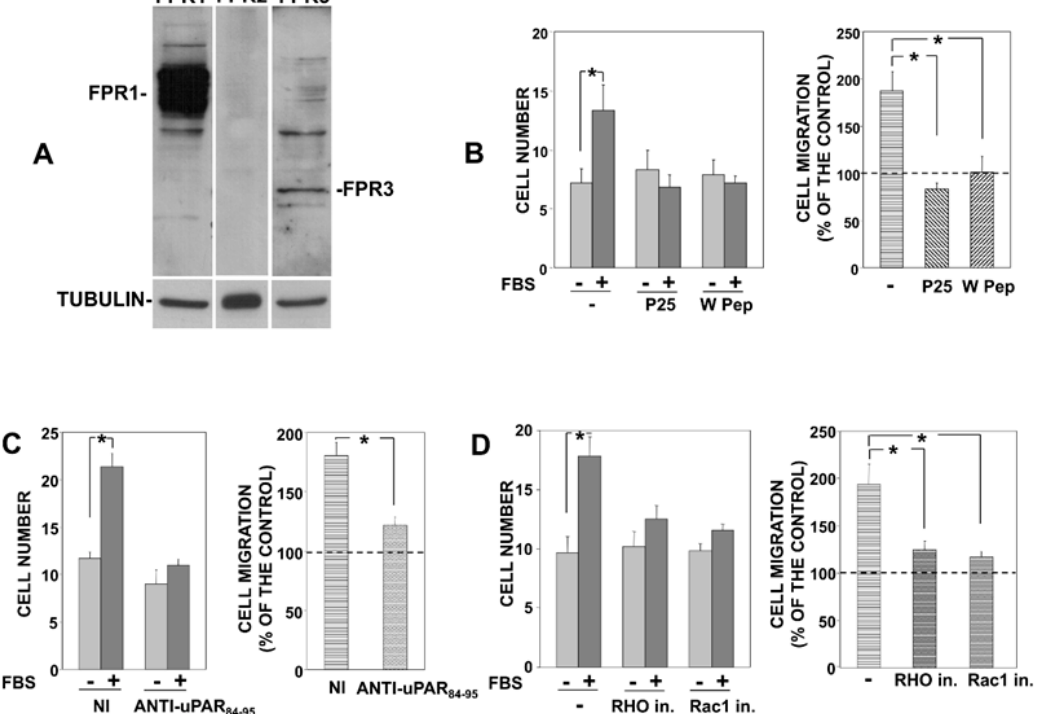
Figure 1. uPAR interactions with FPR1 and β 1 integrins are involved in migration of prostate carcinoma PC3 cells. PC3 cells were lysed and 50 µ g of cell extract was analyzed by Western blot with indicated antibodies; membranes were reprobed with an anti-tubulin mouse antibody for loading control ( A ). PC3 cells were pre-incubated with diluent ( − ) or 5 nM W Peptide (W Pep) or 50 µ M P25 ( B ) or with 5 µ g / mL nonimmune Ig (NI) or an antibody directed to 84–95 uPAR residues ( C ) or with diluent ( − ) or 10 µ M Rho kinase inhibitor or 20 µ M Rac1 inhibitor ( D ). Cells were then plated in Boyden chambers and allowed to migrate towards 10% fetal bovine serum (FBS). Migrated cells were fixed, stained with hematoxylin, and counted (( B – D ) left panels). Results of migration assays are also expressed as percentage of cells migrated towards serum over the cells migrated without serum; 100% values represent cell migration in the absence of chemoattractants (( B – D ) right panels). The values are the mean + SD of three experiments performed in triplicate. (*) p < 0.05, as determined by the Student’s t -test.